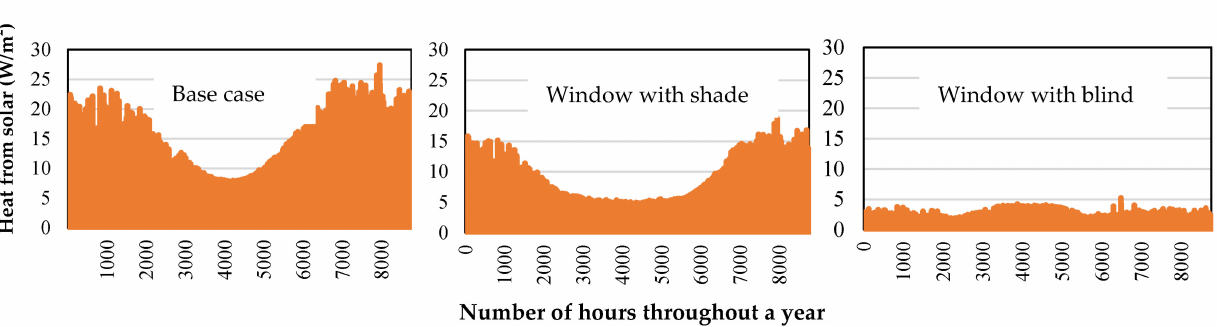
Figure 8. Heat from solar—direct and diffuse for the three studied cases for WWR 30%, for southern exposure, when using the two-pane window with Argon inside (2/Arg) in buildings located in Steppe, cold, arid climate (Bsk) (at 35 ◦ 41 (cid:48) N latitude).